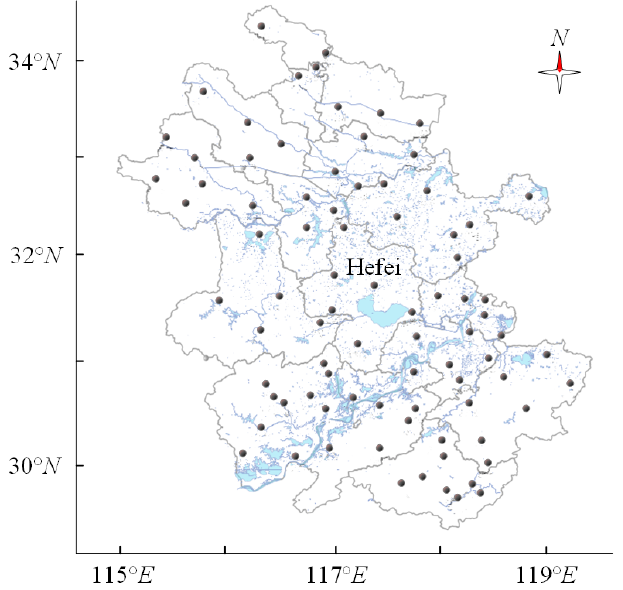
Figure 5. Map of cameras/stations (gray points) for the visibility observation.